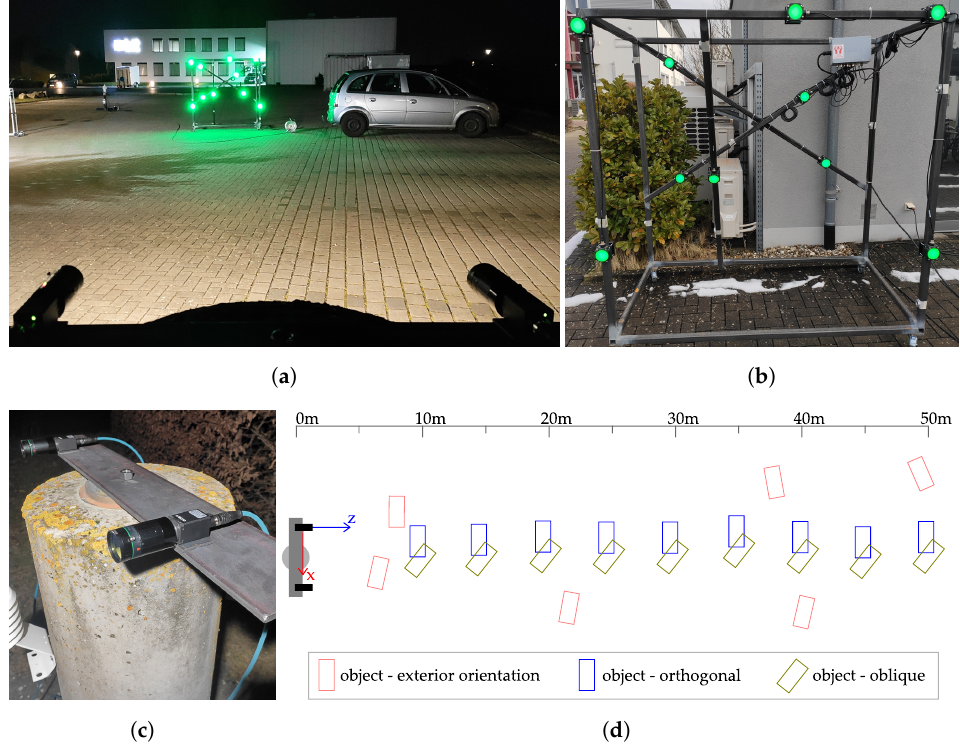
Figure 12. Overview of the experimental setup ( a ) with the object to measure ( b ) and the measuring pillar with the stereo camera system ( c ). A sketch shows the test setup with visualization of the camera coordinate system and the various positions of the object ( d